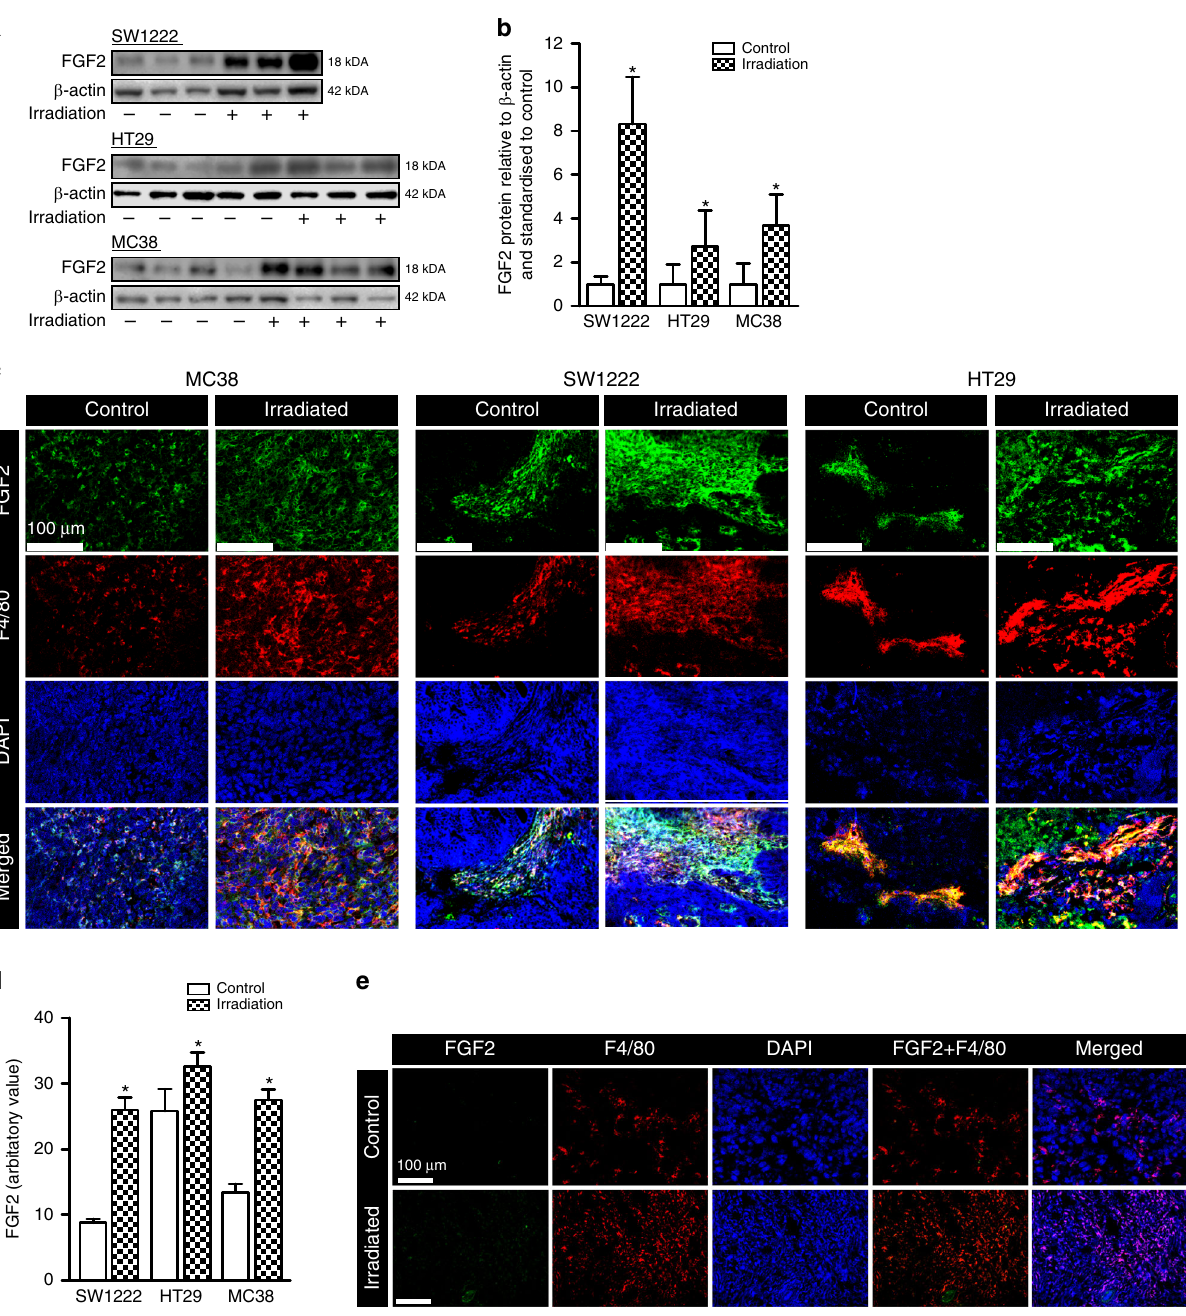
Fig. 6 Effect of Irradiation on FGF2 in tumours. a Representative western blot images of FGF2 in SW1222, HT29 and MC38 tumours following irradiation. b Quanti fi cation of Western blot images. c Representative images of F4/80 and FGF2 confocal imaging in MC38, SW1222 and HT29 tumours following irradiation. d Quanti fi cation of FGF2 from immuno fl uorescent images in ( c ) following irradiation. e Representative images of FGF2, F4/80, DAPI and combined images of FGF2 and F4/80 or all signals merged from immunohistochemistry and confocal imaging of MC38 tumours grown in syngeneic mice. * represents statistical signi fi cance compared with control mice ( p ≤ 0.05). Error bars indicate